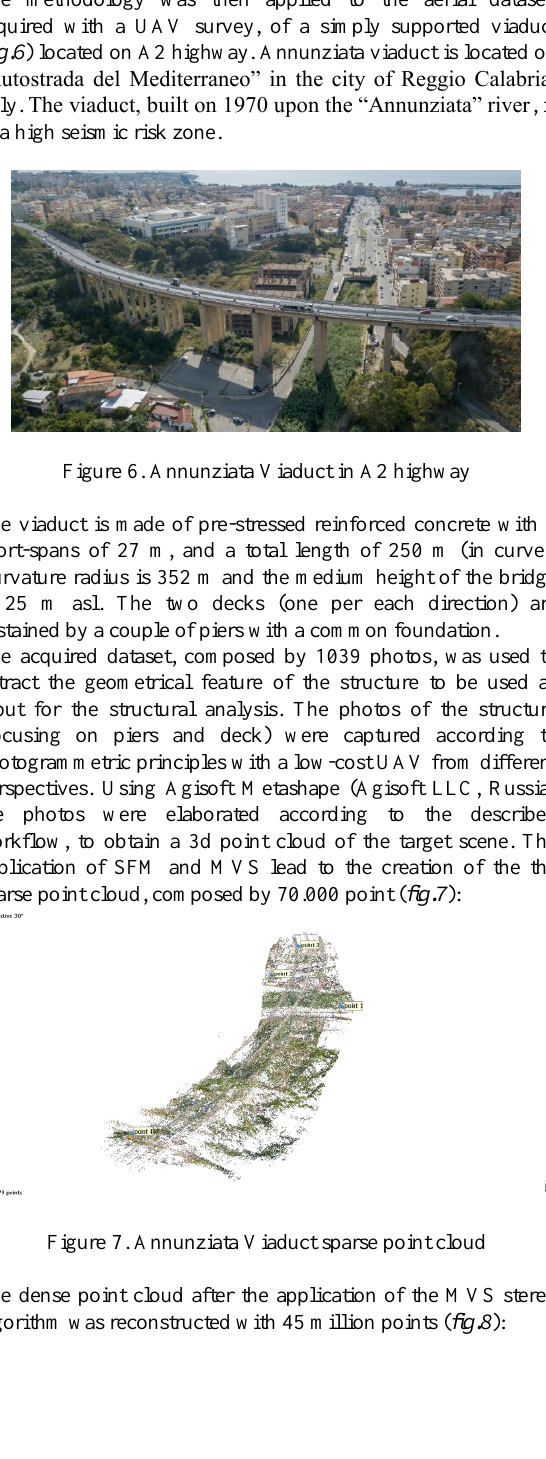
Figure 5. Mask R-CNN for bridge (b) and piers (c) segmentation